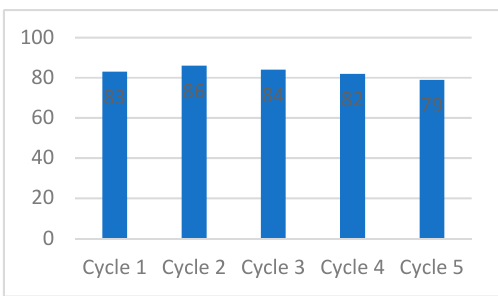
Figure 1. Yield of the selected product 7a for the synthesis in choline ionic liquids.